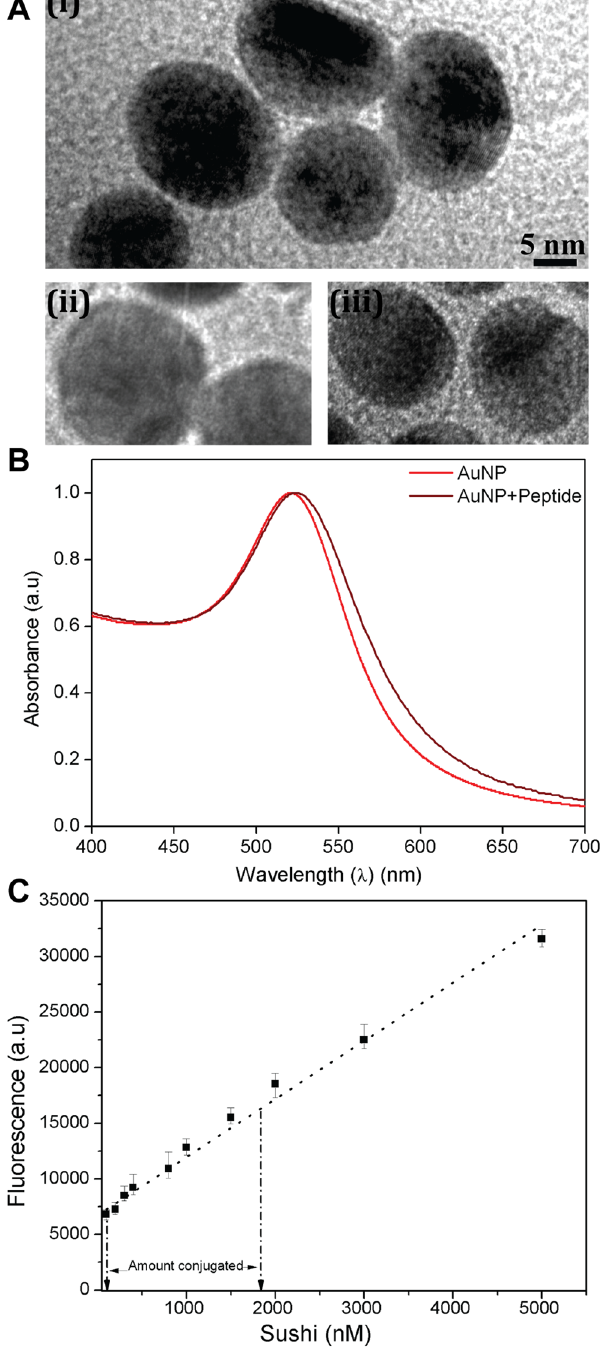
Figure 2. ( A ) TEM images of unmodified AuNPs (i) and AuNPs after conjugation with peptide (ii) and PMB (iii). ( B ) UV-visible spectra of AuNPs depicting a red-shift in their peak absorbance after conjugation with sushi peptide ( Δλ max = 4 nm). ( C ) OPA calibration charts for quantifying the amount of peptide molecules linked to the AuNPs. (Linear least square